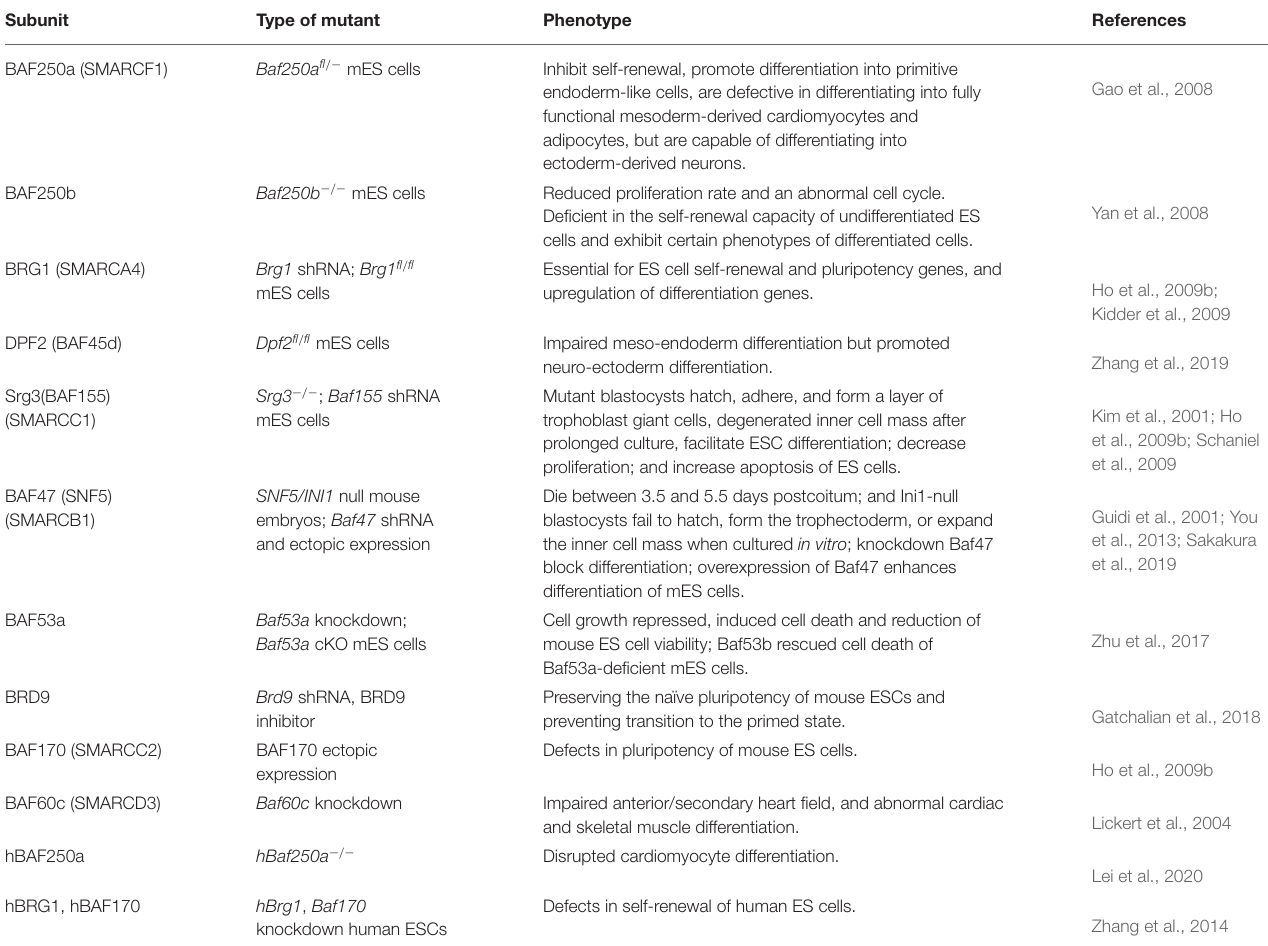
TABLE 1 | BAF subunits and their role in embryonic stem cells (ESCs).